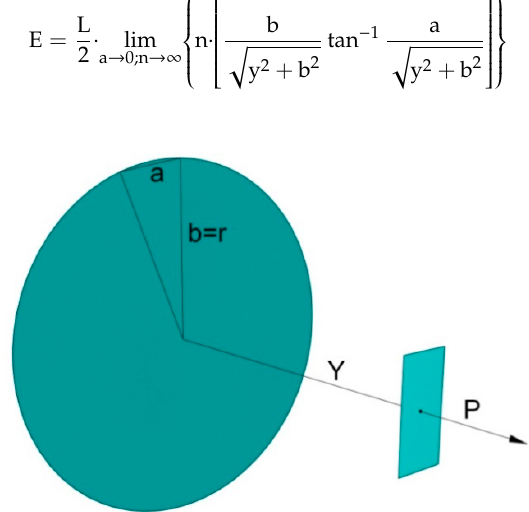
Figure A2. Configuration factor between a hexagon composed of 12 rotated triangles and a point under the center in a parallel plane.